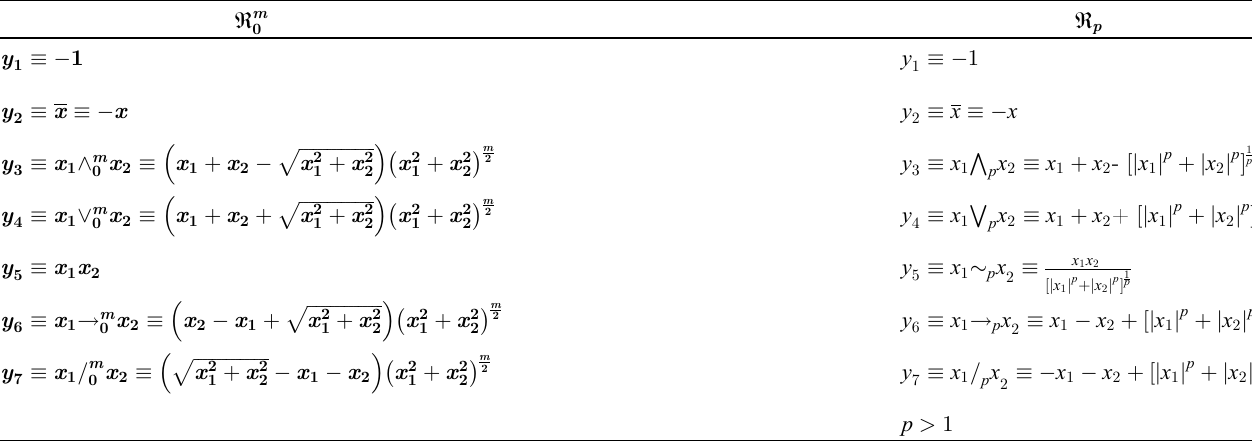
Table 7. Examples of R-functions for the most common Boolean functions.